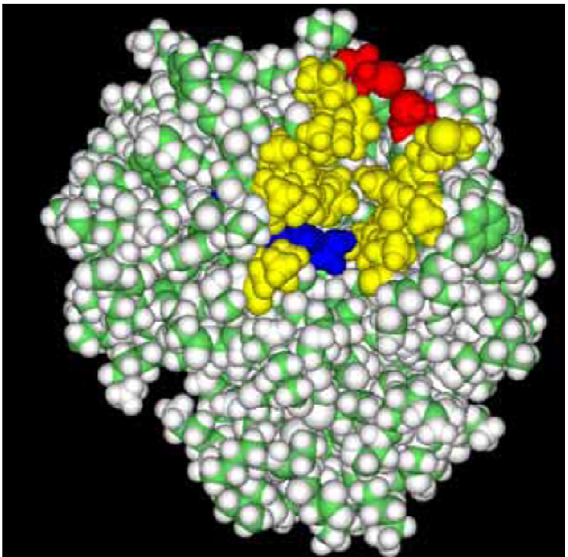
Figure 7. Time course of solvent-free conversion of soy bean oil to fatty acid methyl esters by RCLCYS and RCL at 40 6 C.